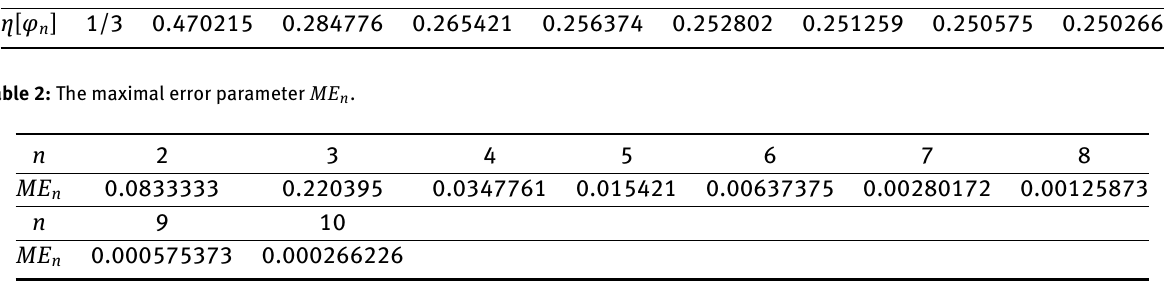
Table 1: The values of η [ φ n ] for n = 2, 3 . . . , 10 . n